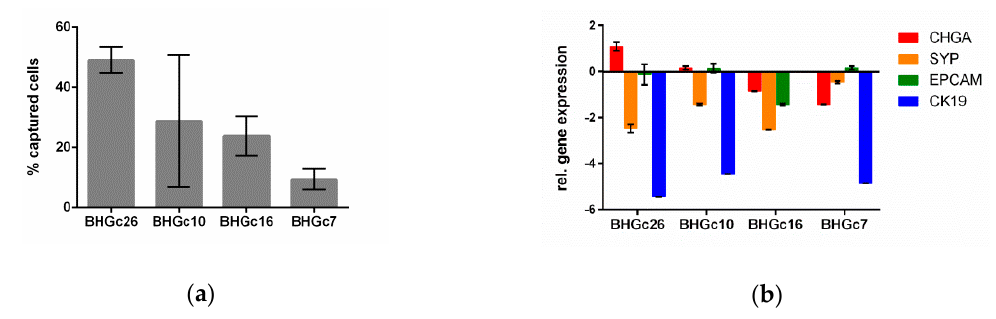
Figure 1. Characteristics of the microfluidic enrichment procedure and of the tumor cell lines used for the spiking experiments are illustrated. ( a ) Four SCLC tumor cell lines (BHGc26, BHGc10, BHGc16, and BHGc7) were fluorescently labeled and spiked into blood (100 cells per 10 mL) in triplicates. The graph depicts the mean percentage and the standard deviation of tumor cells captured in the Parsortix ™ microfluidic cassette. ( b ) The gene expression levels of the epithelial and neuroendocrine cell lineage specific markers of the same cell lines are shown relative to the expression level of cyclin dependent kinase inhibitor 1B as reference gene. The graphs depict the means and the standard deviation from duplicate qPCRs amplifications.